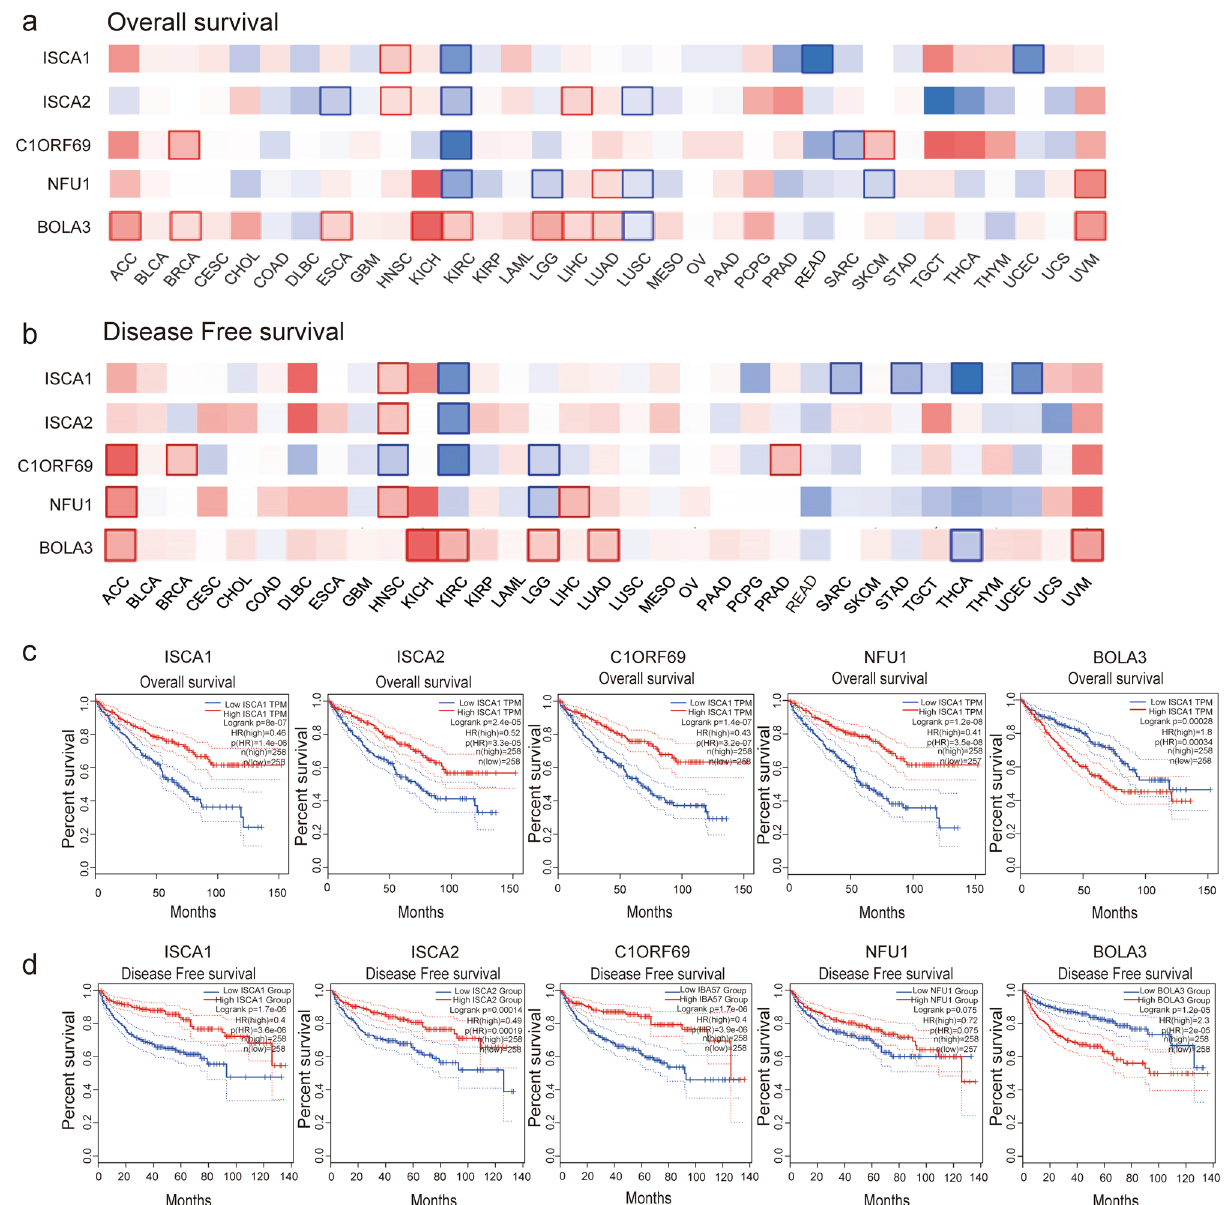
Figure 2. Prognostic feature of the mRNA expression among different MMDS related iron–sulfur protein genes in different types of cancers. Survival map of ( a ) overall survival (GEPIA), ( b ) and disease-free survival (GEPIA) of ISCA1, ISCA2, IBA57, NFU1 and BOLA3. ( c ) Kaplan–Meier curves for MMDS related iron–sulfur protein genes in KIRC patients (OS); ( d ) Kaplan–Meier curves for MMDS related iron–sulfur protein genes in KIRC patients (RFS). ACC adrenocortical cancer, BLCA bladder cancer, BRCA breast cancer, CESC cervical cancer, CHOL bile duct cancer, COAD colon cancer, DLBC large B-cell lymphoma, ESCA esophageal cancer, GBM glioblastoma, HNSC head and neck cancer, KICH kidney chromophobe, KIRC kidney clear cell carcinoma, KIRP kidney papillary cell carcinoma, LAML acute myeloid leukemia, LGG lower grade glioma, LIHC liver cancer, LUAD lung adenocarcinoma, LUSC lung squamous cell carcinoma, MESO mesothelioma, OV ovarian cancer, PAAD pancreatic cancer, PCPG pheochromocytoma & paraganglioma, PRAD prostate cancer, READ rectal cancer, SARC sarcom, SKCM melanoma, STAD stomach cancer, TGCT testicular cancer, THCA thyroid cancer, THYM thymoma, UCEC endometrioid cancer, UCS uterine carcinosarcoma, UVM ocular